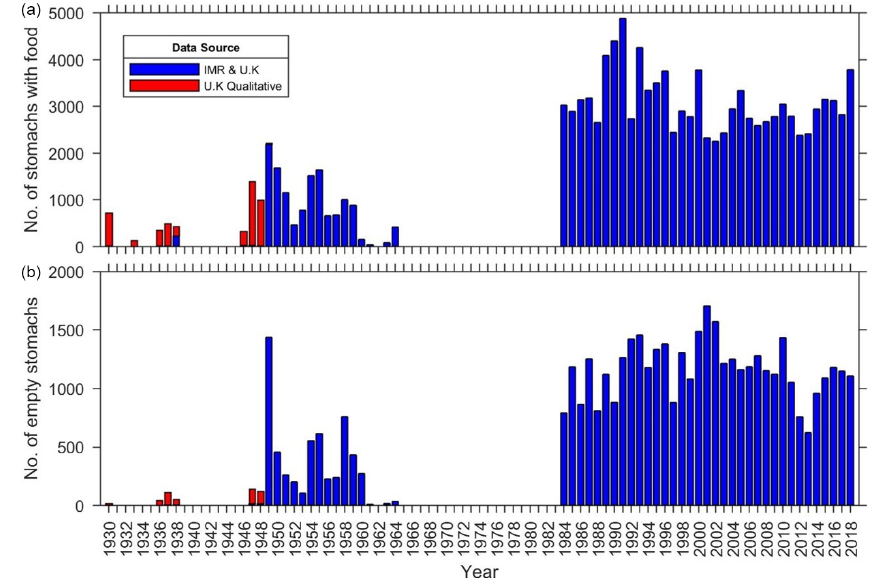
Figure 2. Number of stomachs sampled in each year, showing those with food contents (a) and those that were empty (b) .